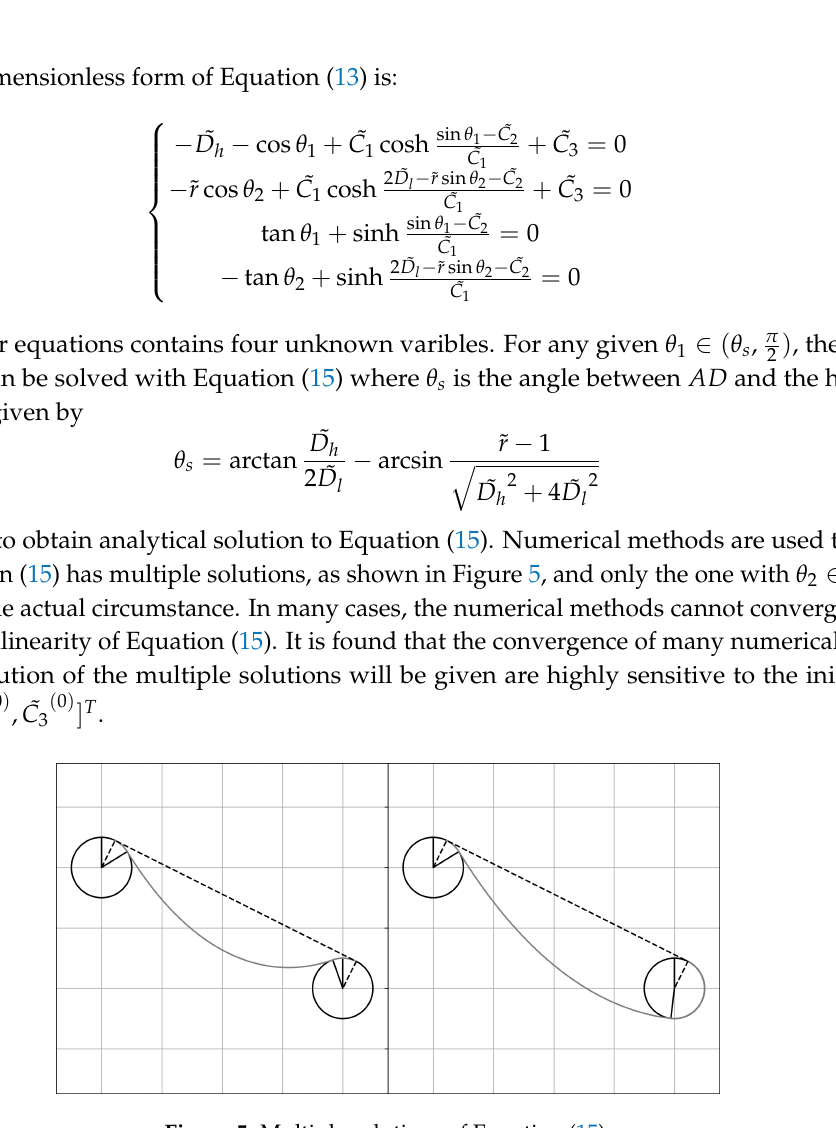
Figure 5. Multiple solutions of Equation